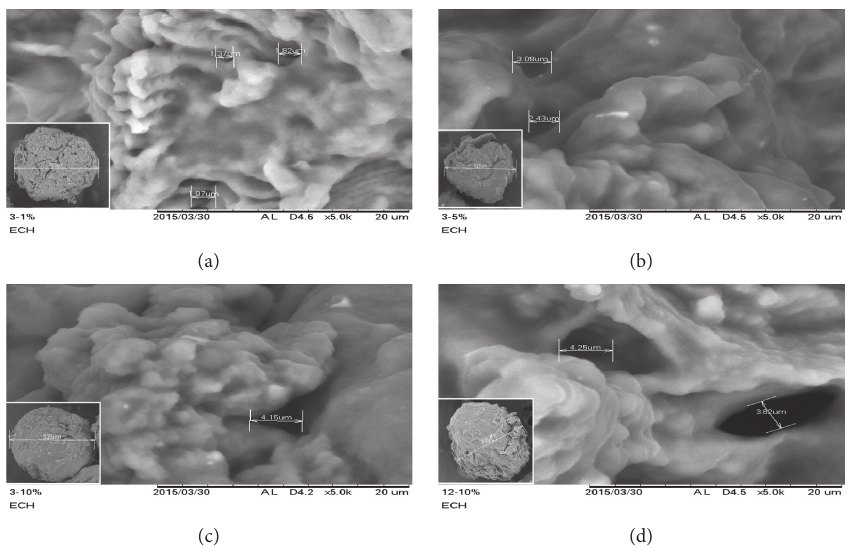
Figure 4: SEM images of cross-linked chitosan beads using 5% (v/v) ECH immersed in TPP 1% for 3h (a), TPP 5% for 3h (b), TPP 10% for 3h (c), and TPP 10% for 12h (d) with magnification of 5000x. Inset pictures are SEM images of the beads with a magnification of 100x.